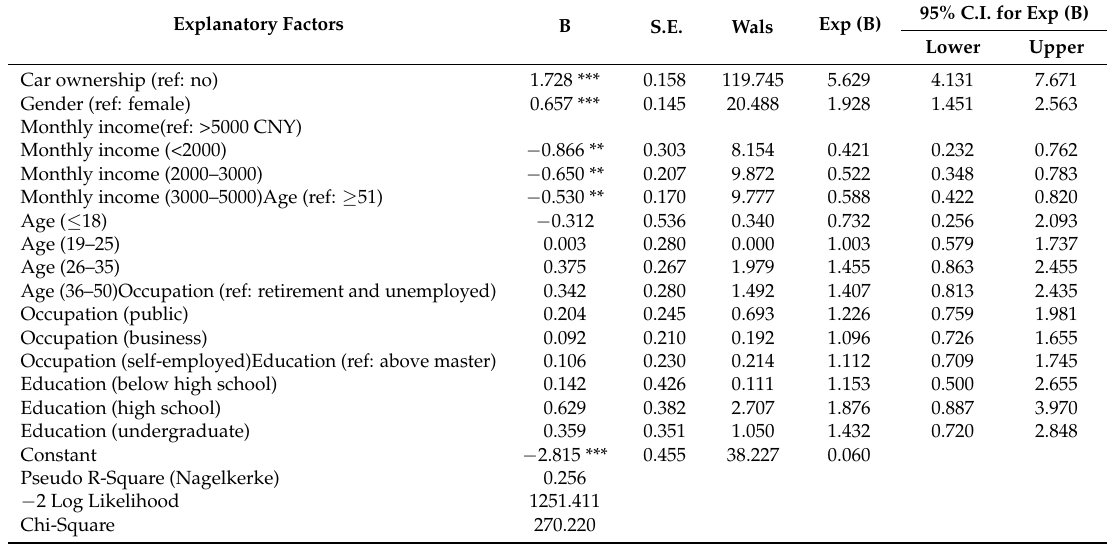
Table 3. Logistic regression results of impacts on transport mode choice during shopping